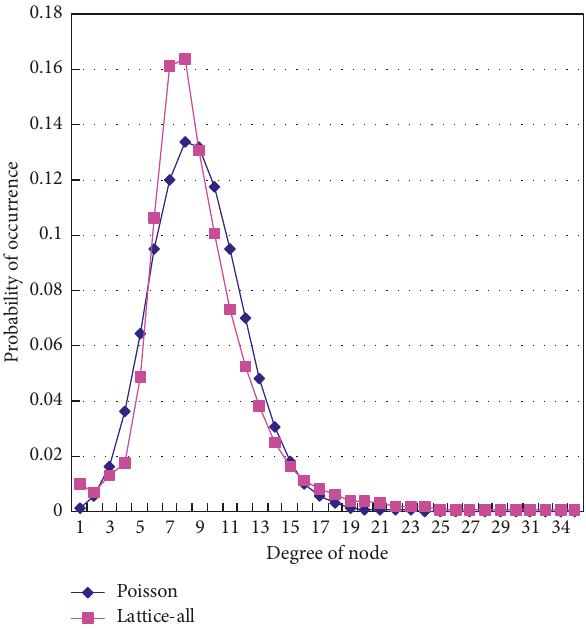
Figure 11: Poisson distribution curve fitting